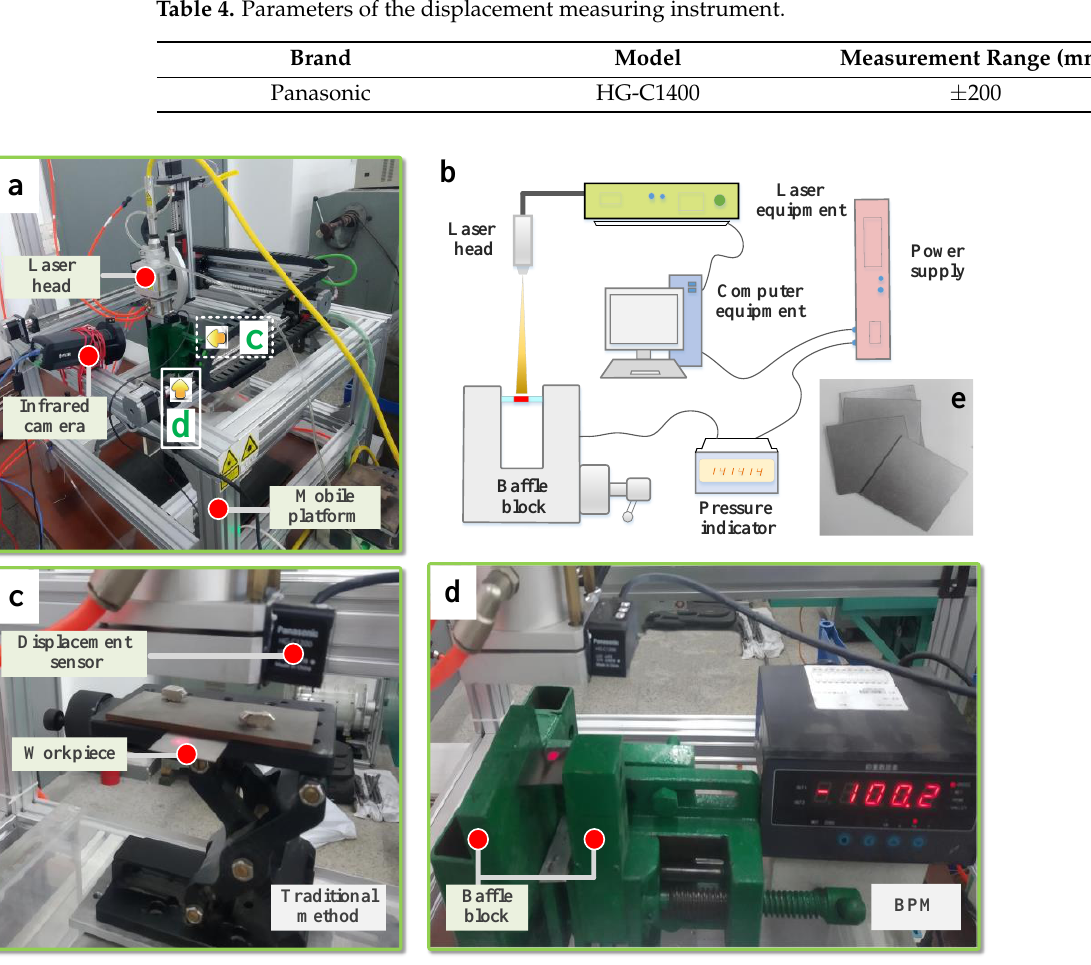
Figure 5. Experimental site: ( a ) overall diagram of the experimental equipment, ( b ) overall schematic of BPM, ( c ) the traditional method, ( d ) BPM and ( e ) experimental plate. Some typical parameters are selected for the experimental validation (Table 5). The bending angles are compared in Figure 6a (average error of 5.26%), and the temperature peaks are compared in Figure 6b (average error of 4.84%). The simulation results are ac- curate. Table 5. Typical parameters. No.